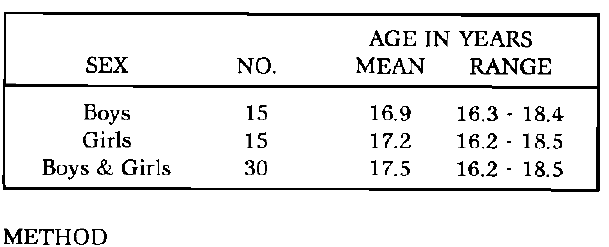
Table 1: Number, age and sex of subjects taking part in